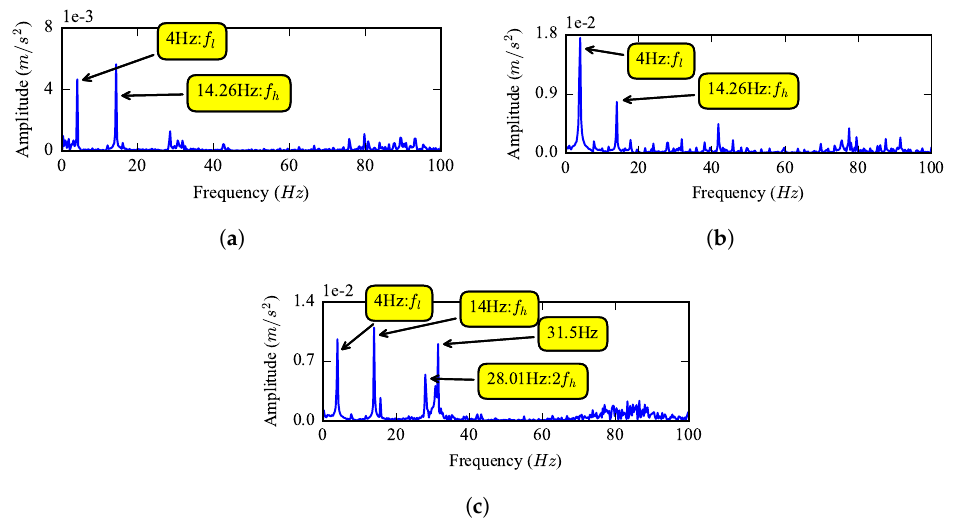
Figure 15. Partial enlarged view of the experimental spectrum of the ring vertical acceleration of the ( a ) healthy gear, ( b ) half tooth breakage fault gear and ( c ) the whole tooth breakage fault.